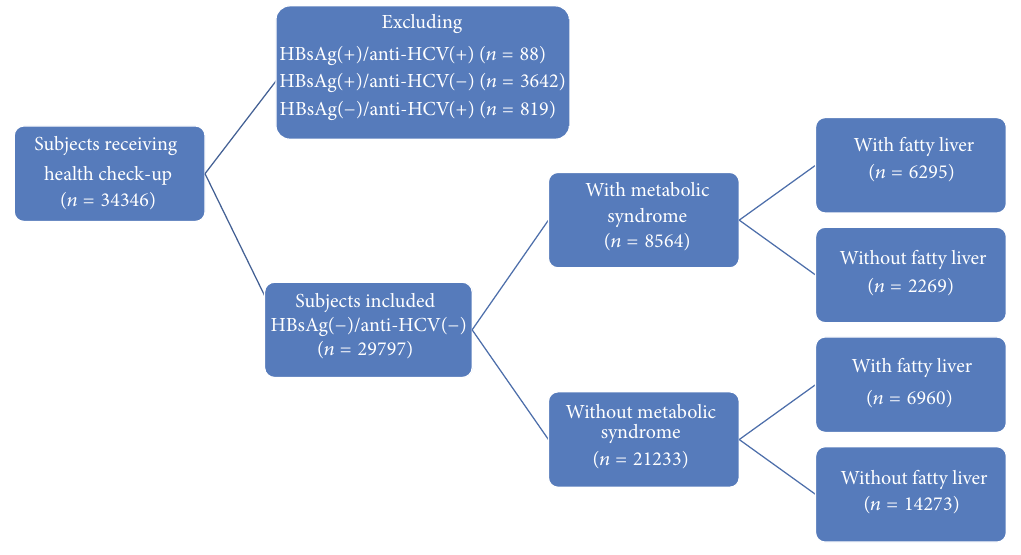
Figure 1: The algorithm for patient